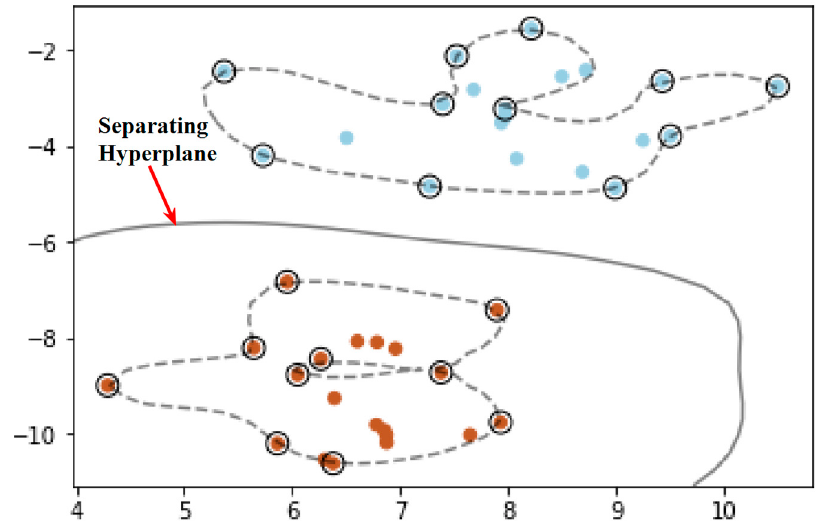
Figure 3. SVM demo for separating two nonlinearly separable classes via a hyperplane by using a Gaussian kernel